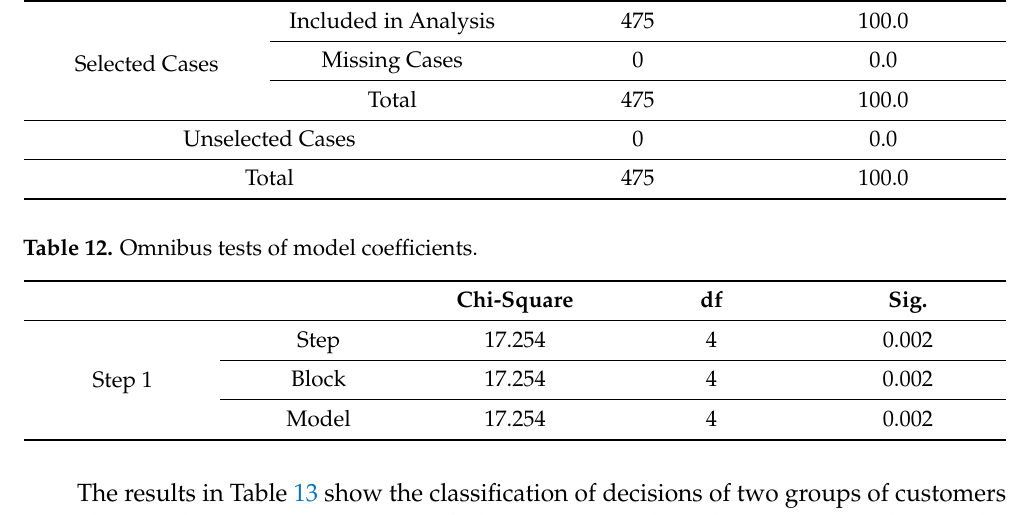
Table 11. Case processing summary.